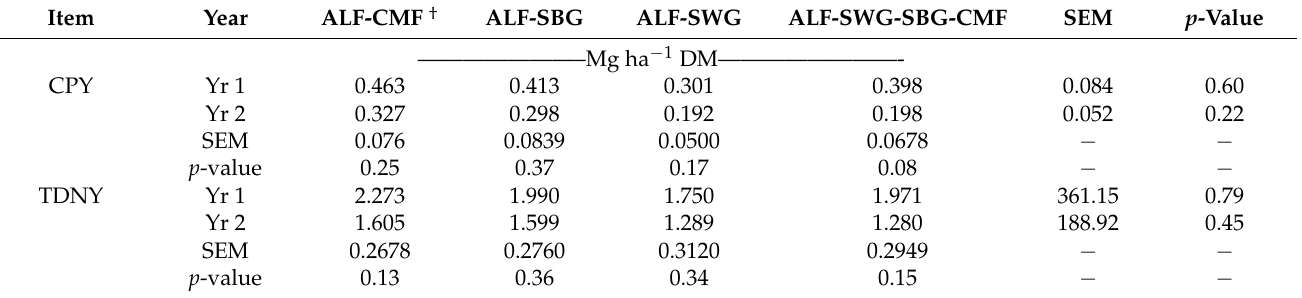
Table 6. Nutrient yield of ‘Halo’ alfalfa and grass mixtures in Clavet, Saskatchewan, Canada over